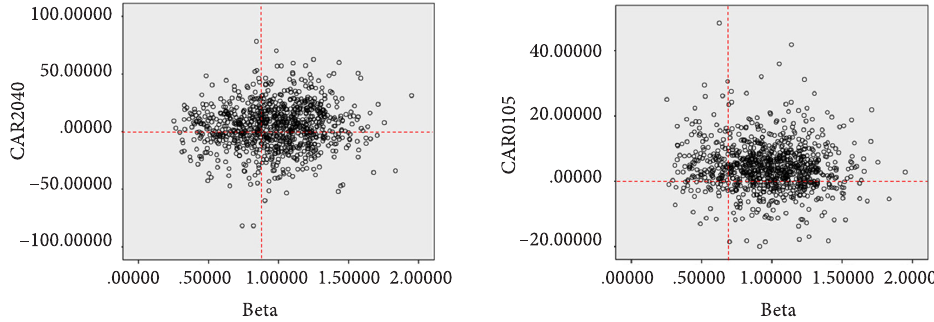
Figure 3. The frequency distribution graph and summary of statistics of the pre-repurchase